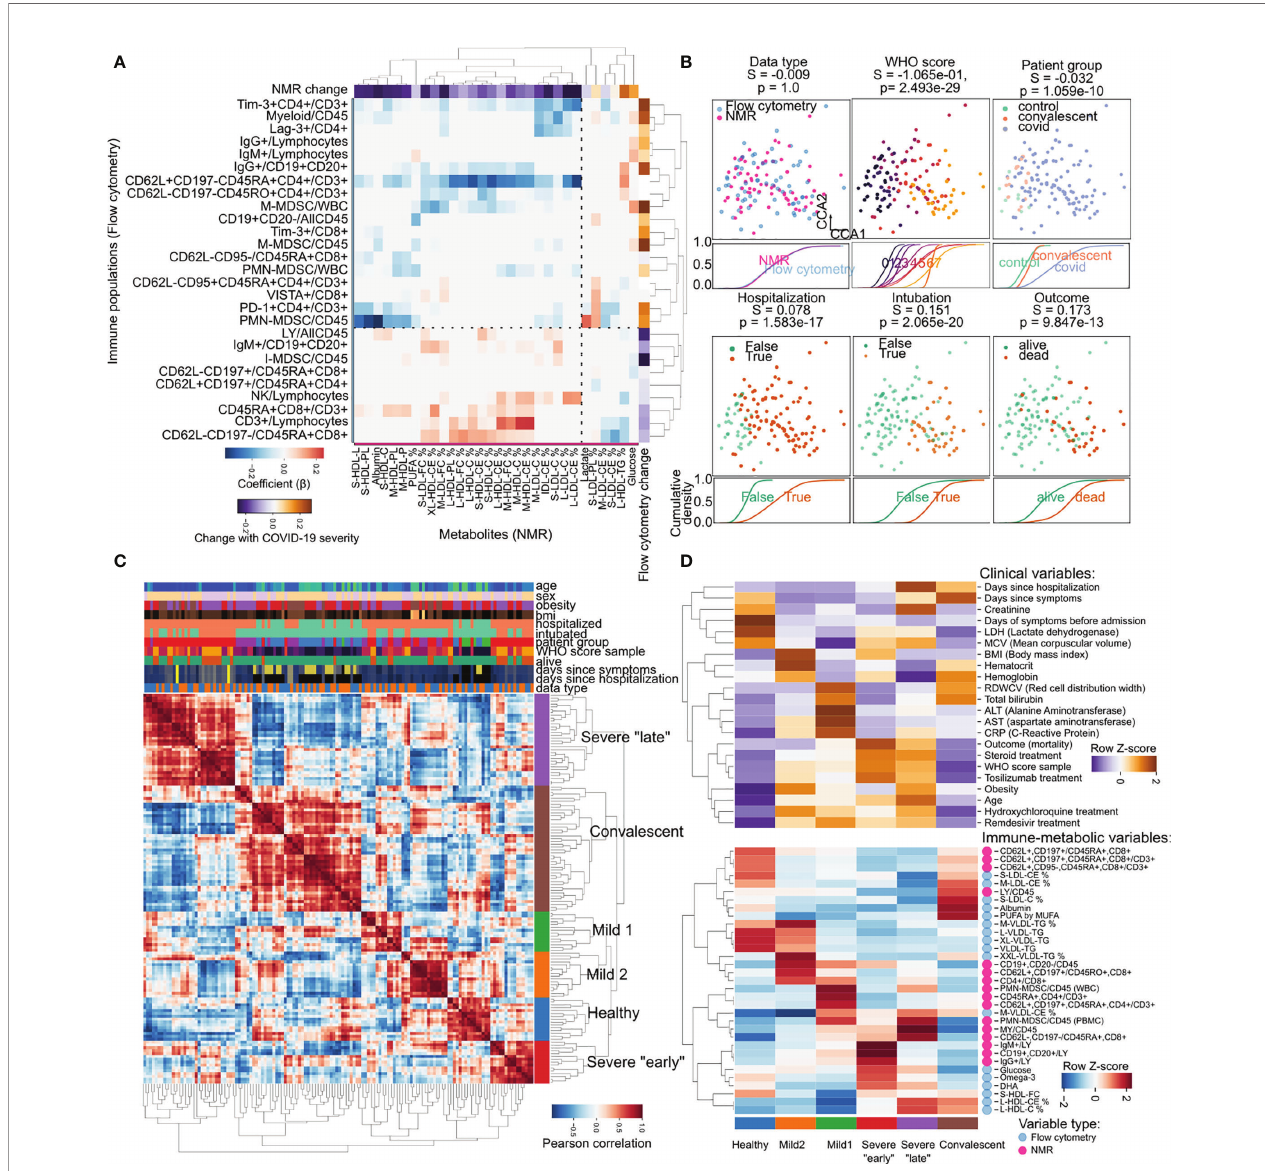
FIGURE 4 | Joint immune-metabolic analysis empowers a novel COVID-19 patient strati fi cation strategy. (A) Heatmap of the relationship between metabolic (x-axis) and immune variables (y-axis). Values of change with COVID-19 are regression coef fi cients for COVID-19 severity. Only the 30 variables with most variance are shown per dataset. (B) Integration of immune and metabolic data into a joint embedding. Each square panel demonstrates the distribution of samples dependent on clinical factors, and below the cumulative distribution function of each class along the fi rst dimension. We provide silhouette scores (S) for how good the classes are separated and their signi fi cance through an ANOVA test (p). (C) Pairwise correlation heatmap showing the similarity between samples based on immune-metabolic data. The hierarchical clustering dendrogram illustrates the newly discovered patient groups. Axis rows and columns are the same. Values of clinical parameters for every sample are illustrated above the heatmap. (D) Relative enrichment of sample groups in clinical (top) and immune-metabolic variables (bottom). Values were aggregated by mean per cluster and row-wise Z-score transformed to account for the heterogeneous nature of the